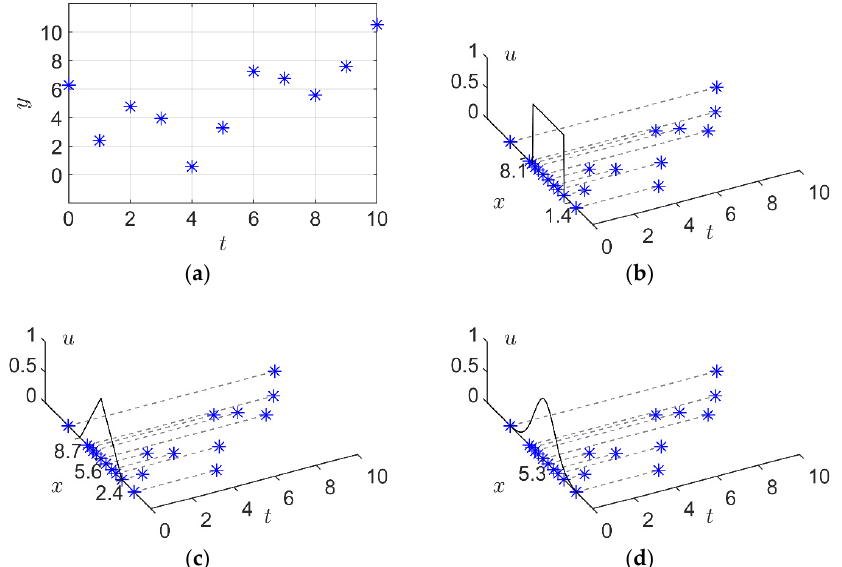
Figure 2. Different types of fuzzy information granules. ( a ) time series data; ( b ) interval fuzzy infor- mation granule; ( c ) triangular fuzzy information granule; ( d ) Gaussian fuzzy information